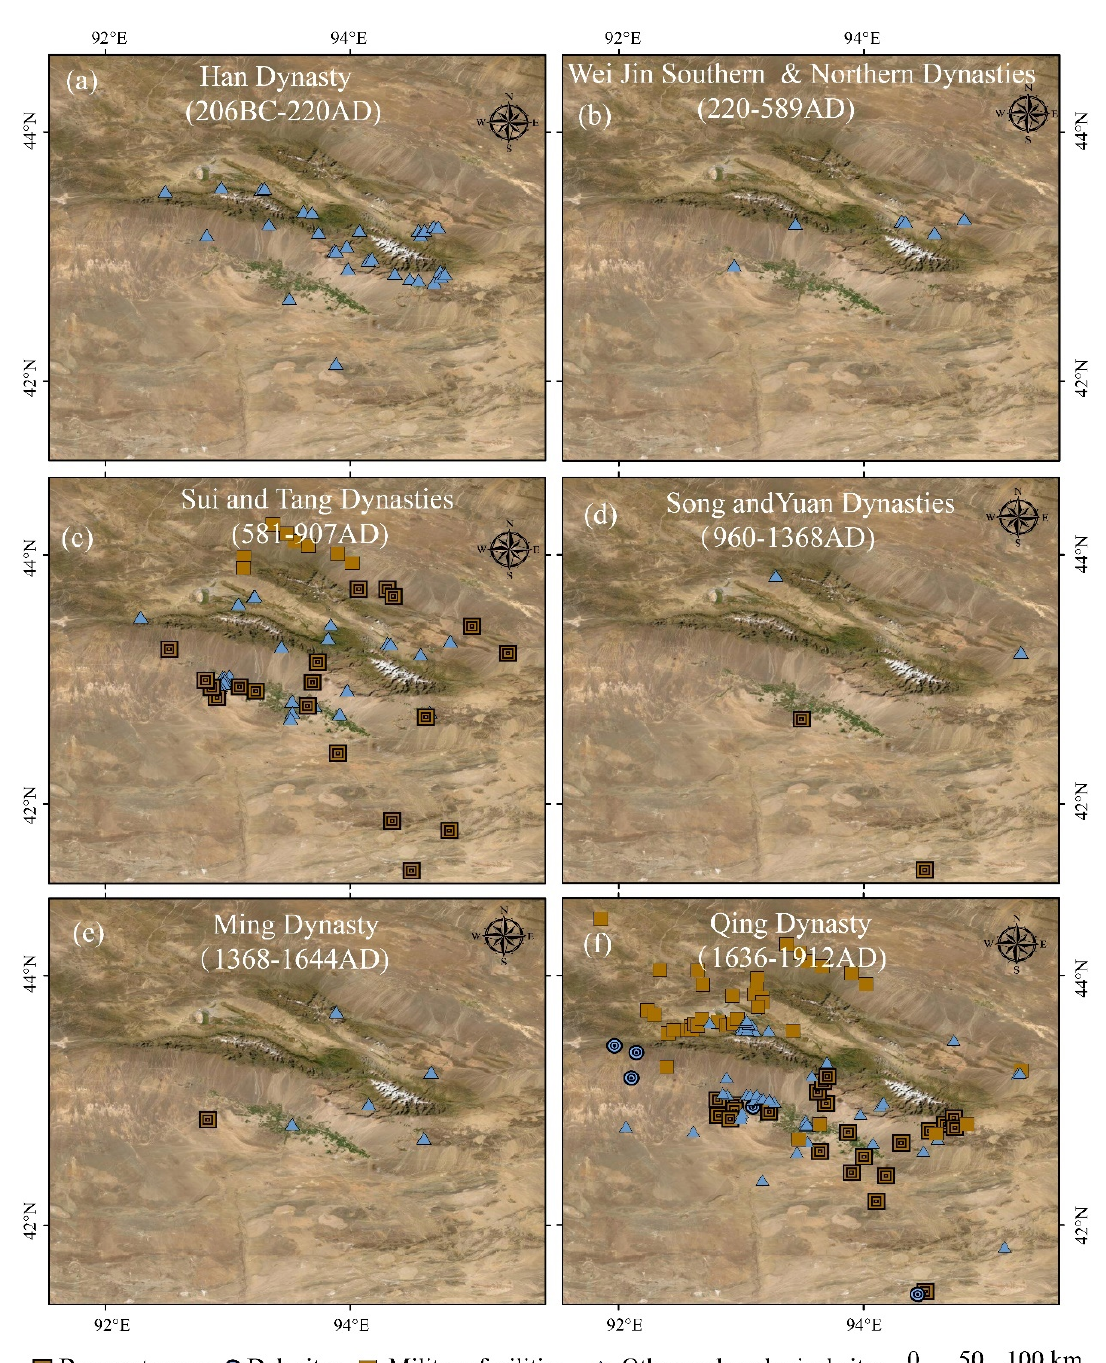
Figure 4. The spatiotemporal distribution of ancient ruins in the Hami region from the Han Dynasty to the Qing Dynasty. Data on the beacon towers and dak sites are from this study; data on military installations and other archaeological sites are from the Third National Cultural Relics Census in the Xinjiang Uygur Autonomous Region.